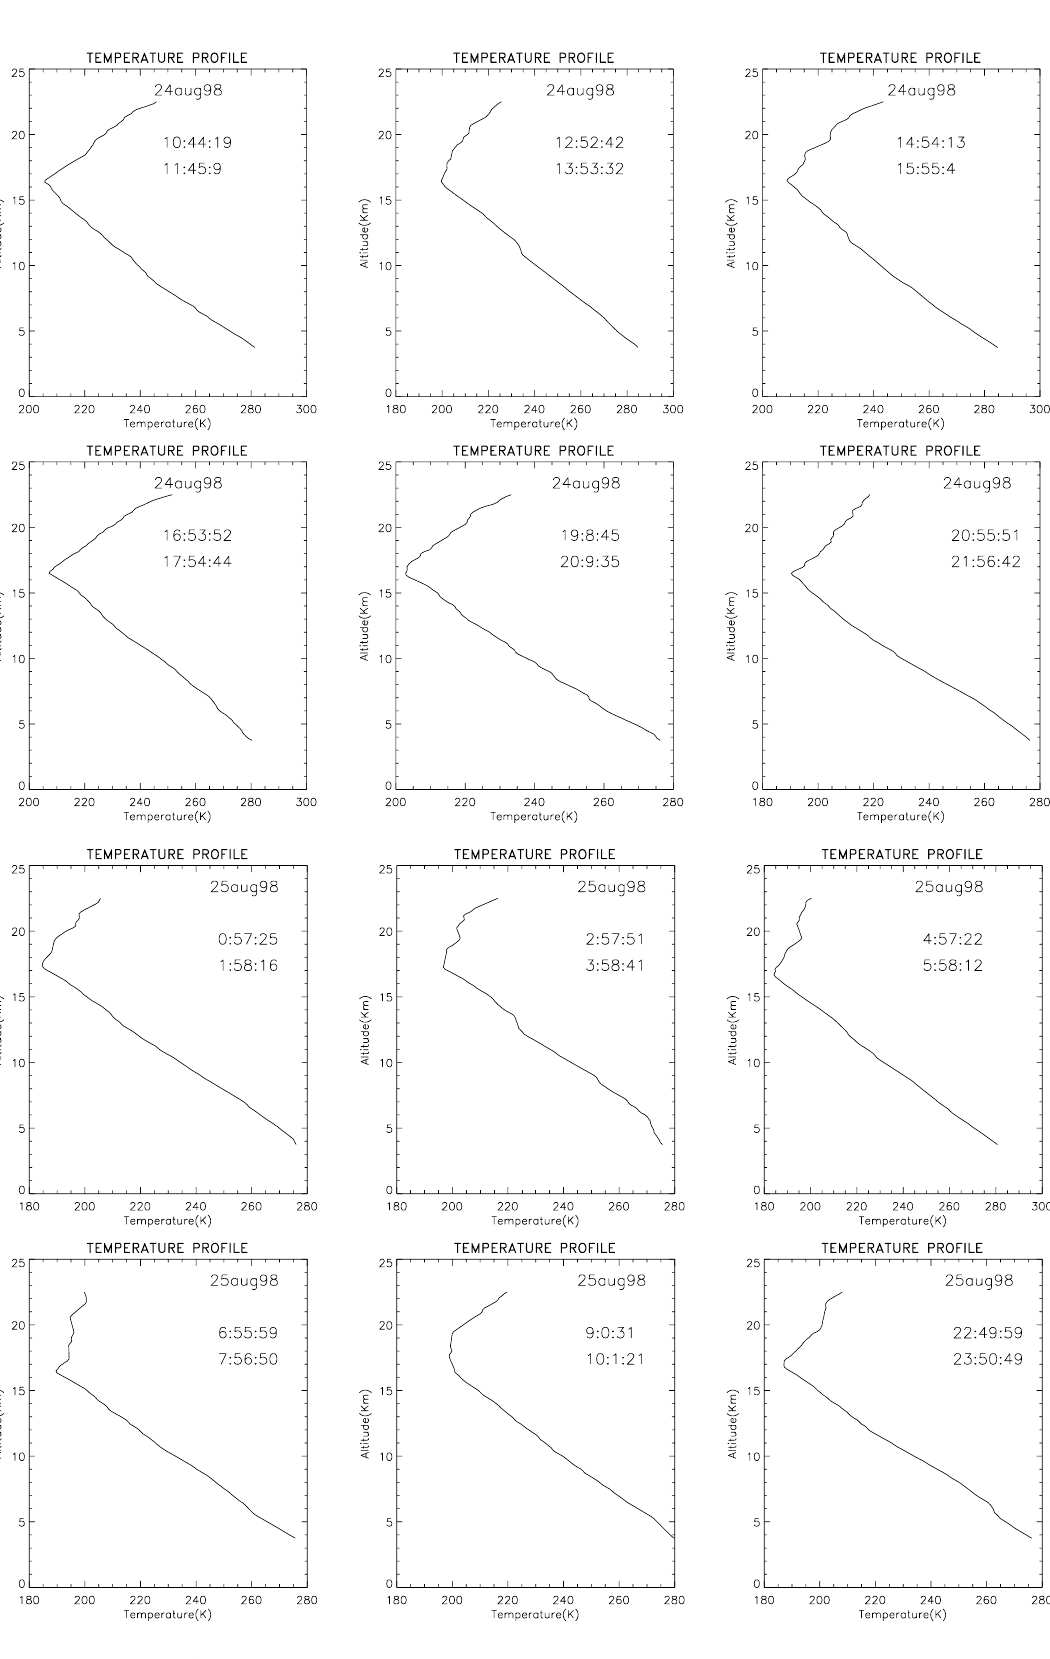
Fig. 3. Twelve vertical profiles of temperature during 10:44 LT on 24 August to 10:01 on 25 August 1998 at regular two hours